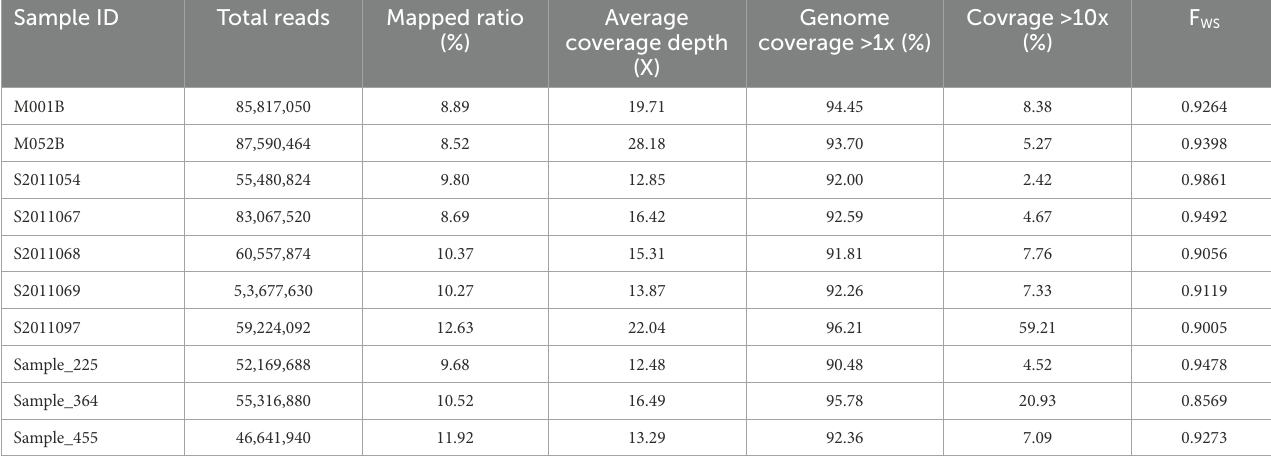
TABLE 2 Sequencing and mapping summary statistics for 10 China inland